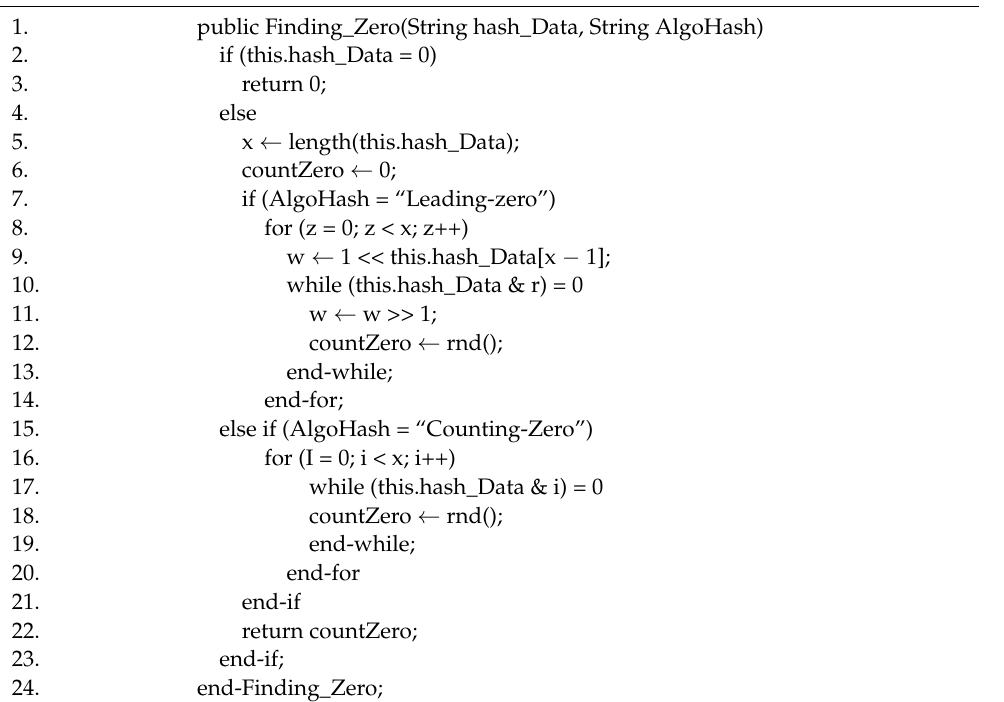
Algorithm 4: Finding-Zero